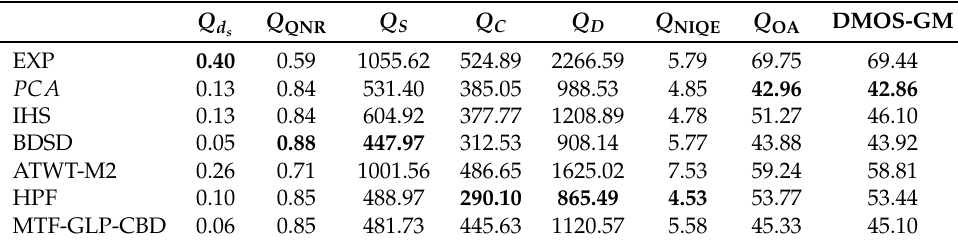
Table 9. IKONOS Roma Villa scene, full-resolution, image quality assessment metrics, and DMOS GM quantitative results. The bold number indicates the best performing PS method according to each quality metric.